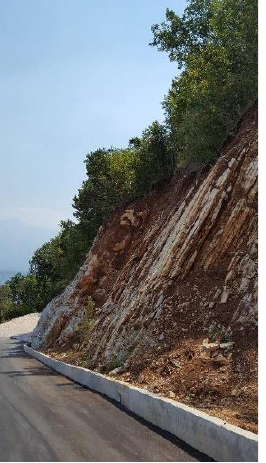
Figure 7. The new road (Source: Kosara Kujundzic)